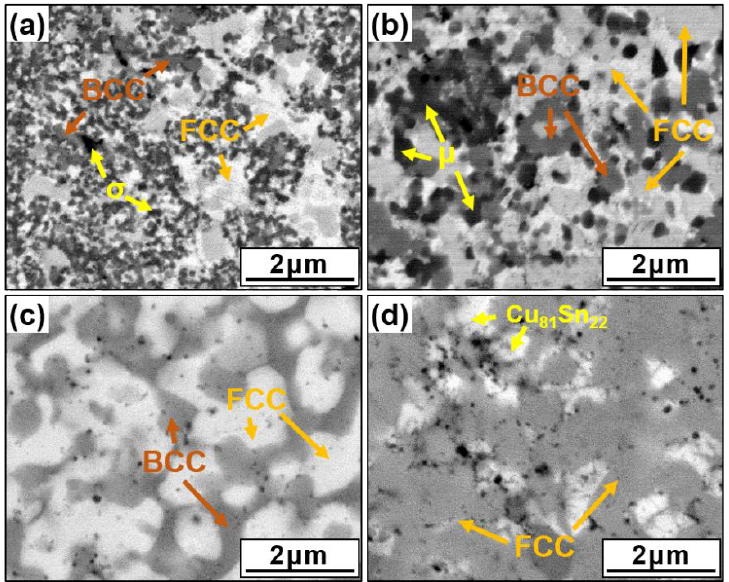
Figure 3. SEM images of the SPSed HEAs. ( a ) AlCuSiFeCr, ( b ) AlCuSiFeMn, ( c ) AlCuSiFeZn, and ( d ) AlCuSiFeSn. Table 2. EDS compositional data of the AlSiFeCuX (X = Cr, Mn, Zn, Sn) alloys in at%.